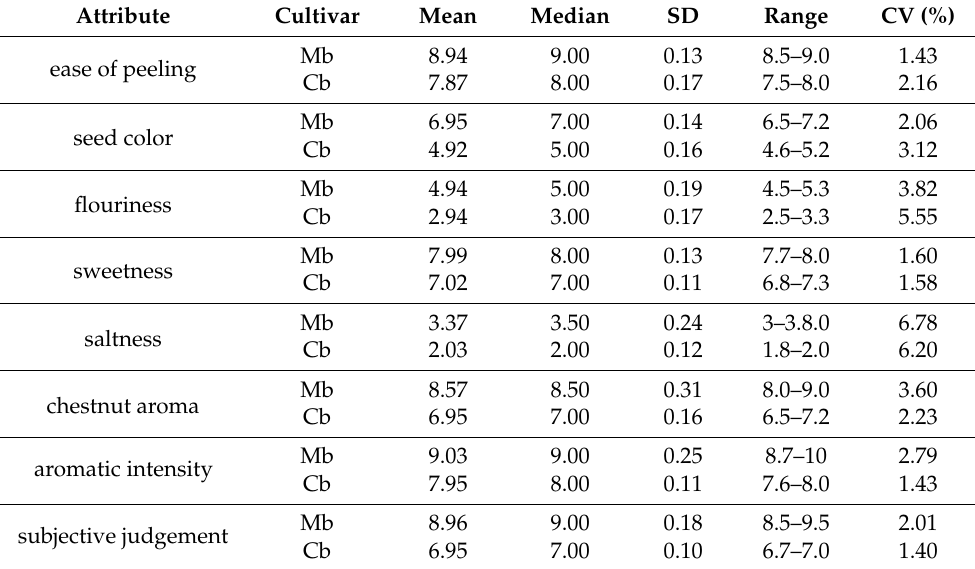
Figure 2. Radar chart for sensory analysis of considered chestnut varieties. Cr: raw Sweet chestnut; Mr: raw Marrone chestnut; Cb: boiled Sweet chestnut; Mb: boiled Marrone chestnut. Table 3. Sensory attributes of boiled Marrone and Sweet chestnut